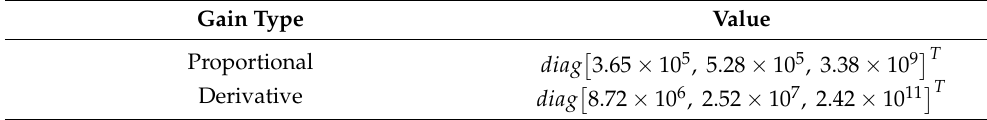
Table 6. Proportional and derivative gains for comparative